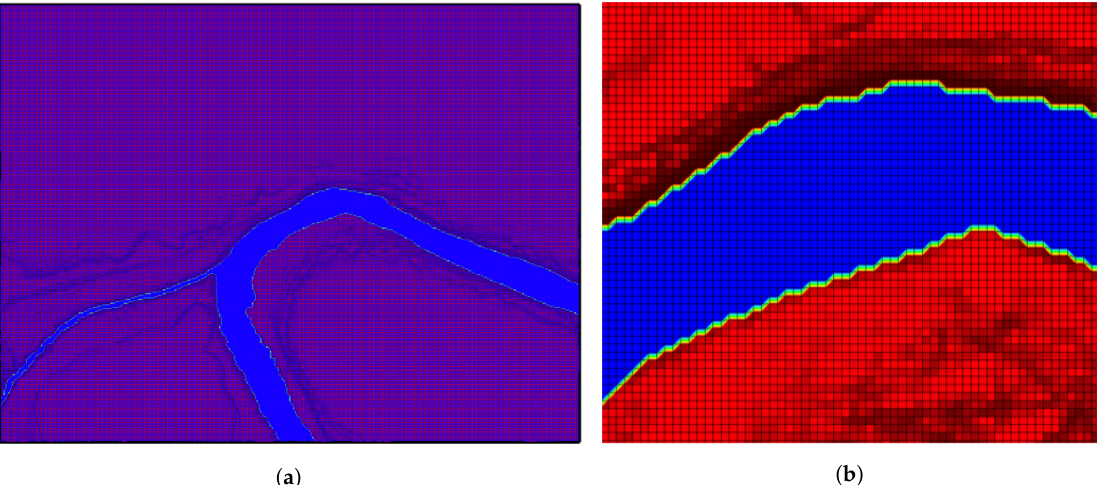
Figure 8. Space discretisation and boundaries location: ( a ) blue, wet cells; purple, dry cells; and ( b )